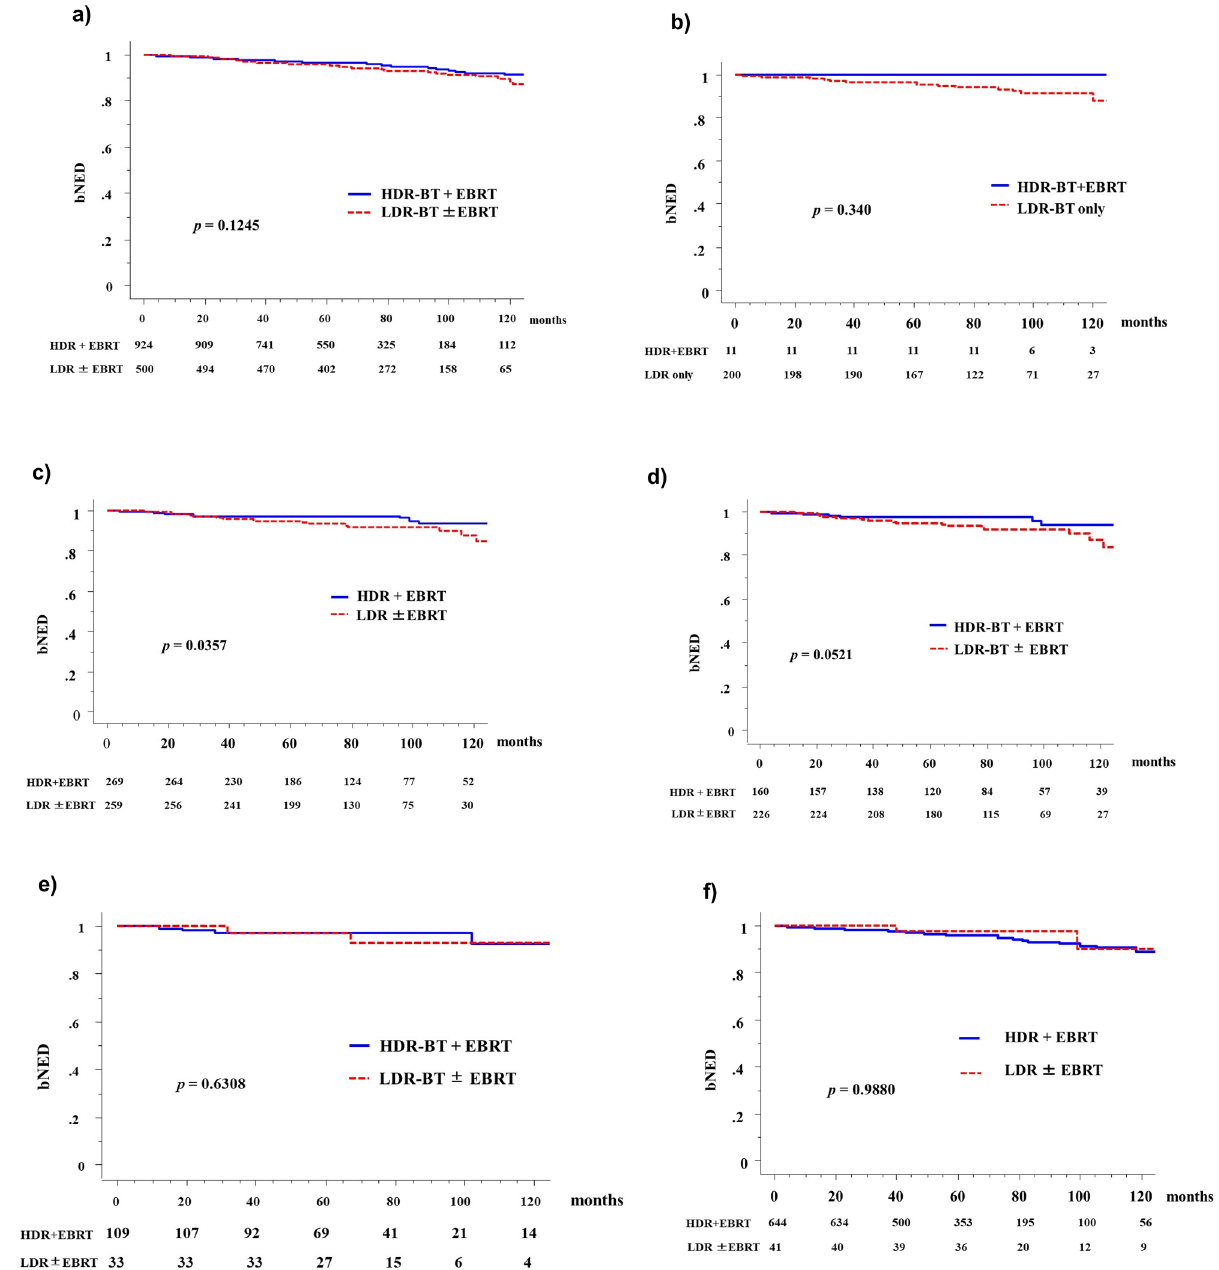
Figure. 2. Biochemical control rates between HDR-BT with EBRT and LDR-BT with or without EBRT. ( a ) Biochemical control rates between HDR-BT with EBRT and LDR-BT with or without EBRT in the total population. ( b ) Low risk group. ( c ) Intermediate group. ( d ) Lower titer of intermediate group. ( e ) Higher titer of intermediate group. ( f ) High risk group. bNED = no biochemical evidence of (22.5% at 10 years), and 12% (18.6% at 10 years) in the HDR-BT, LDR-BT alone, and LDR-BT + EBRT groups ( P = 0.7027, Fig. 5), respectively. The 5-year cumulative incidence rate of grade ≥ 2 GI toxicities was 2.6% (3.9% at 10 years) in the HDR-BT group and 1.6% (1.6% at 10 years) in the LDR-BT group (Fig. 5, P = 0.0820). The 5-year cumulative incidence rates of grade ≥ 2 late GI toxicities were 2.6% (3.9% at 10 years), 1.2% (1.2% at 10 years), and 4.4% (4.4% at 10 years) in the HDR-BT, LDR-BT, and LDR-boosted groups ( P = 0.0630 among the three groups and P = 0.04 between the LDR-BT + EBRT group and LDR-BT only group, Fig. 5), respectively. Details of the late toxicity profile (per event) are shown in Supplemental Table 2. Multivariate analyses revealed that the occurrence of acute grade ≥ 2 GU toxicities predicted the occurrence of late grade ≥ 2 GU toxicities (hazard ratio 2.745, P < 0.0001; Table 6). In addition, EBRT increased the probability